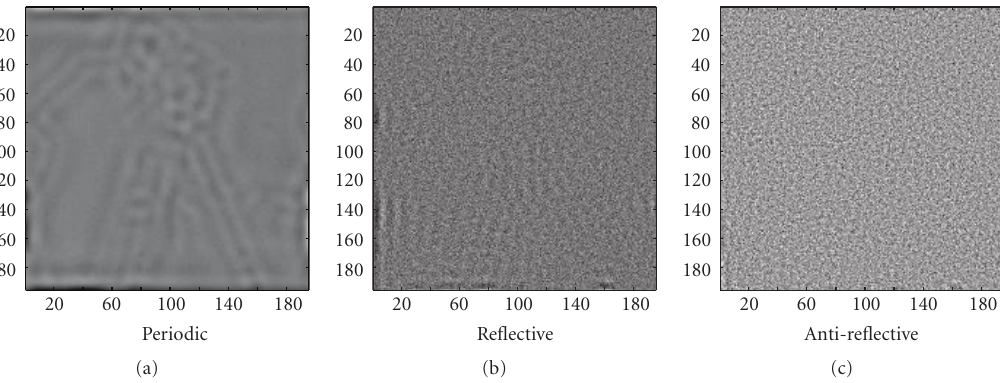
Figure 6: Residuals divided by the variance of the noise for the restored images with SNR = 40.